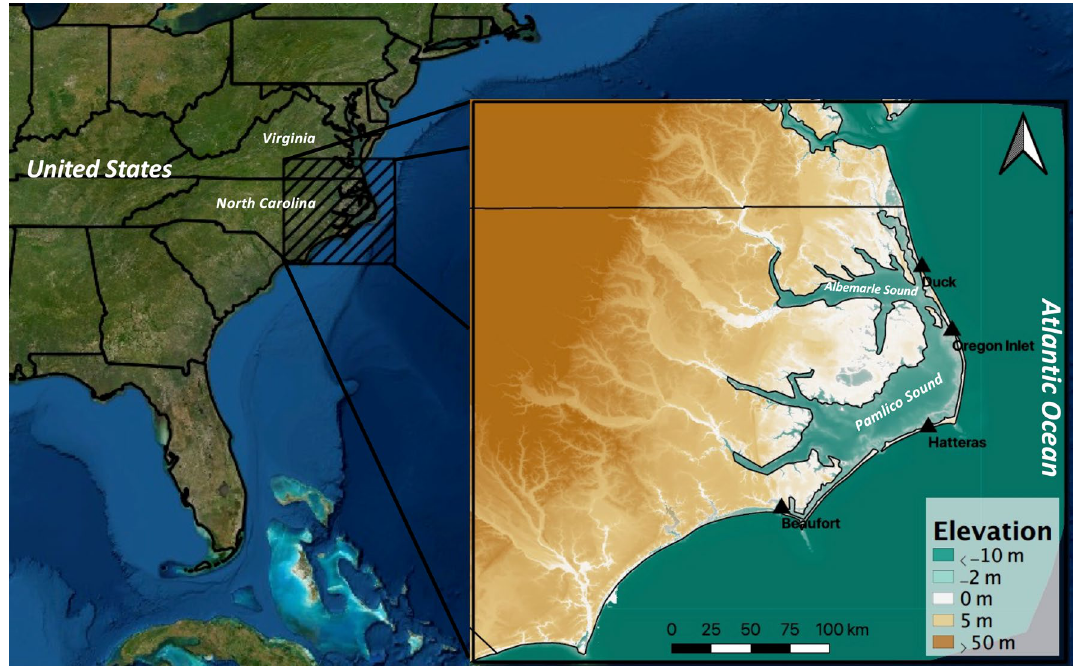
Figure 1. Study region with elevation and bathymetry (CUDEM, Coastal Relief Model, GEBCO, USGS). Water level recording stations indicated. Figure created in QGIS (Version 3.16, https:// qgis. org/ en/ site/ forus ers/ downl oad. html) using ESRI Satellite imagery as